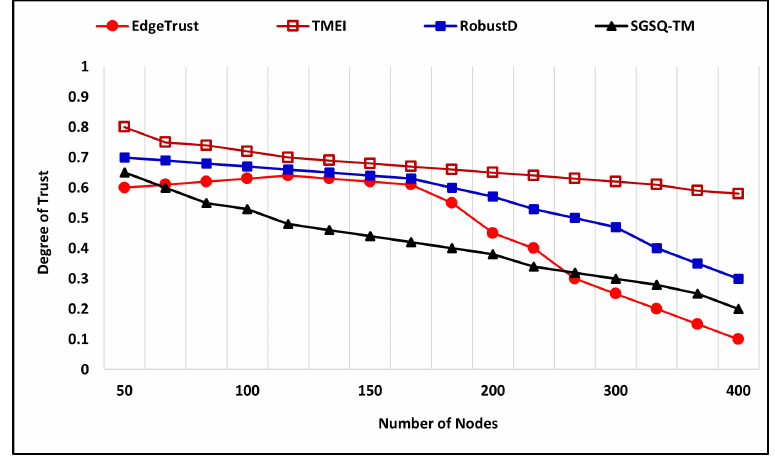
Figure 6. On-off attacks (Scenario-1).